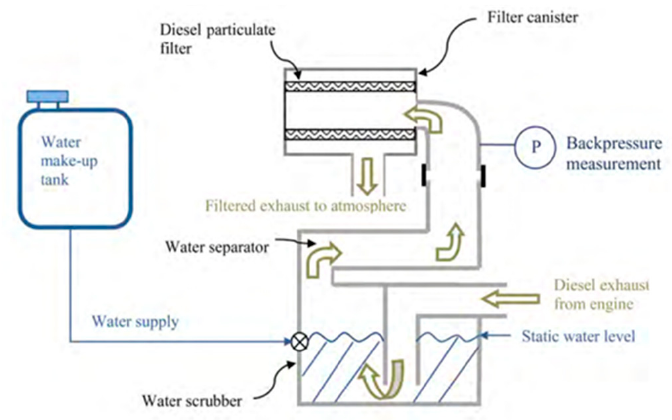
Figure 1. Schematic diagram of the diesel exhaust wet scrubber [7].